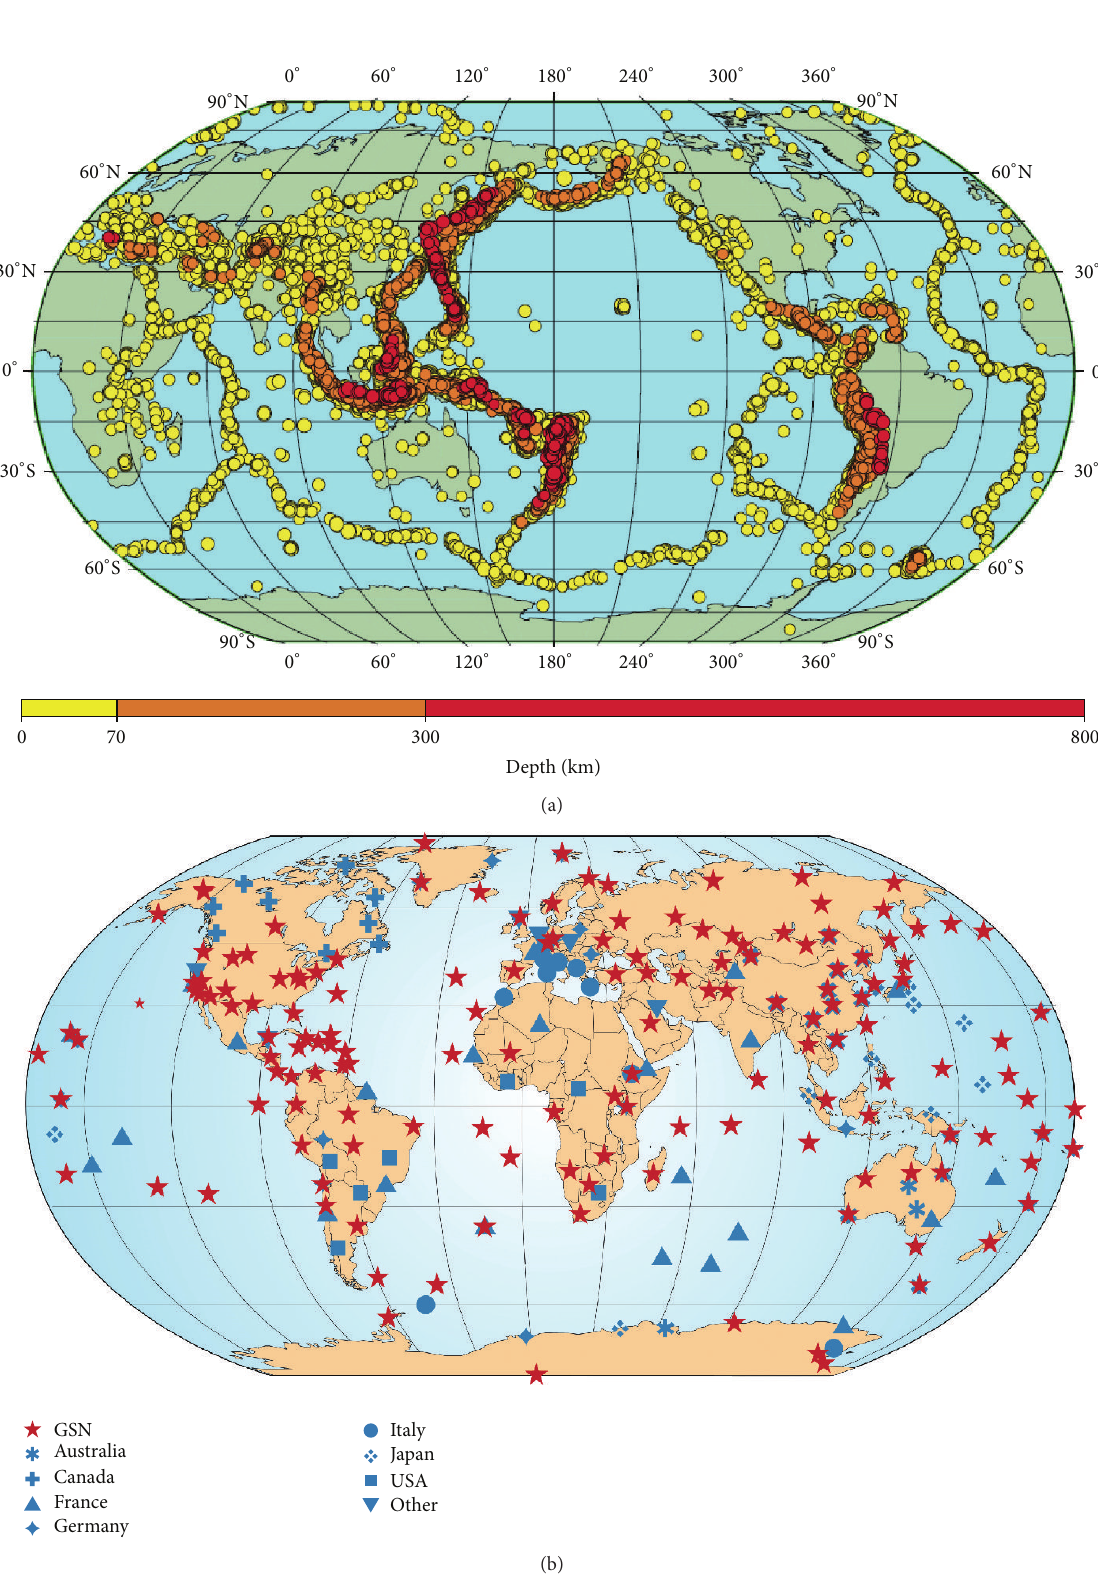
Figure 4: (a) Seismicity and plate boundaries, with focal depth distribution. (b) Global seismic networks (adapted from Romanowicz